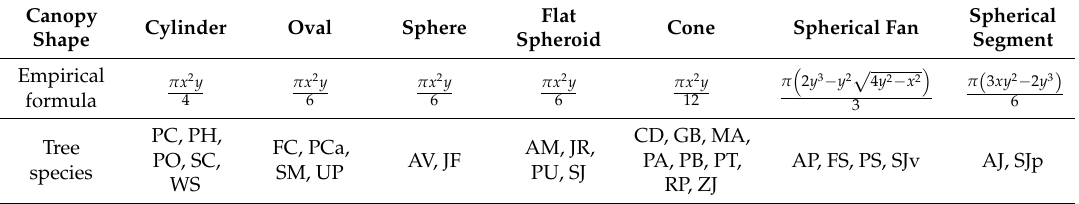
Table 5. Empirical formulae for determining the three-dimensional green biomass of trees [78]. Canopy